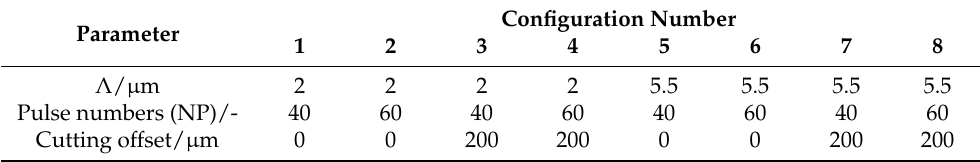
Table 2. Overview of all manufactured tool configurations for the turning experiments.